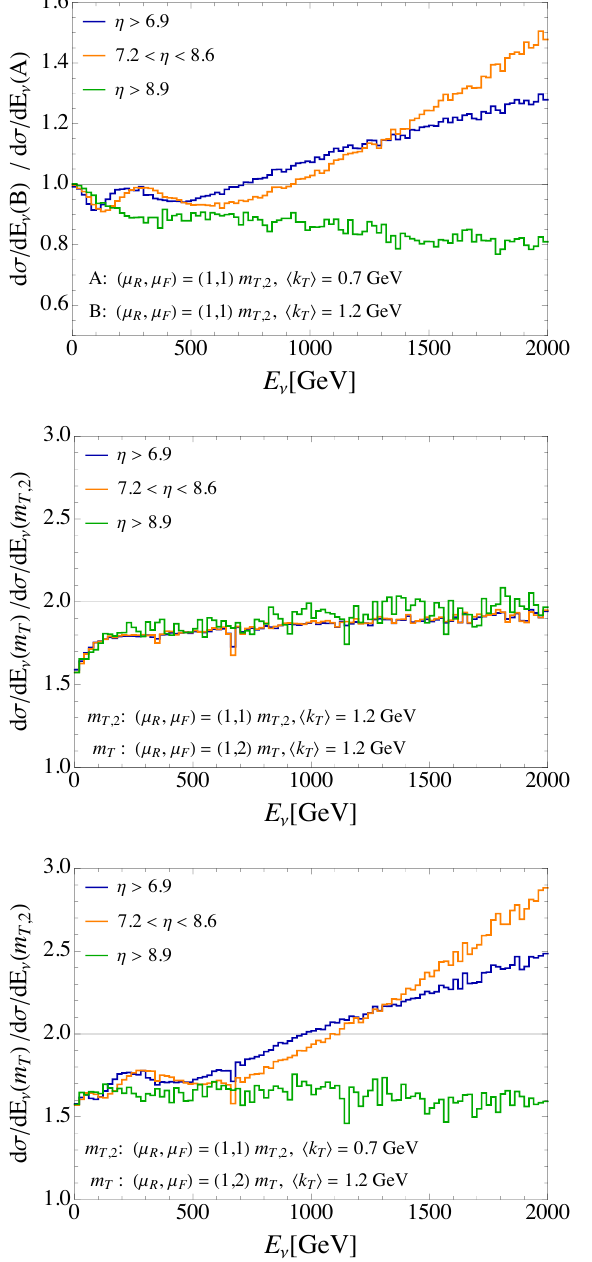
Figure 14. Ratio of the tau neutrino plus antineutrino distribution dσ/dE ν for η ν > 6 . 9 , 7 . 2 < η ν < 8 . 6 and η ν > 8 . 9 . The upper plot has the ratio with m T, 2 scale dependence and h k T i = 1 . 2 GeV (numerator) and 0.7 GeV (denominator). The middle plot has h k T i = 1 . 2 GeV fixed with scale dependence (1 , 2) m T (numerator) and (1 , 1) m T, 2 (denominator). The lower plot has both h k T i and scale differences in the